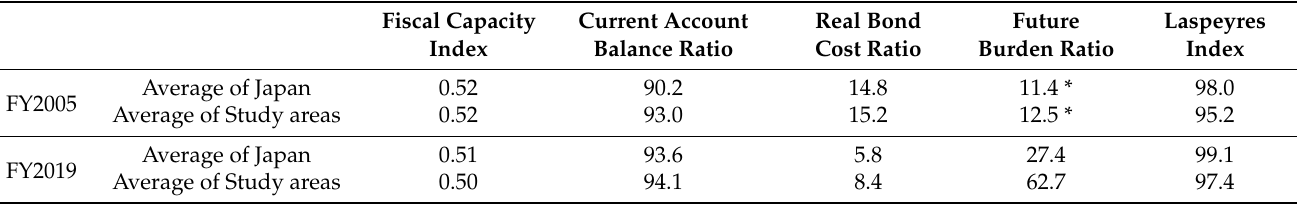
Table 5. Fiscal indicators according to municipality.